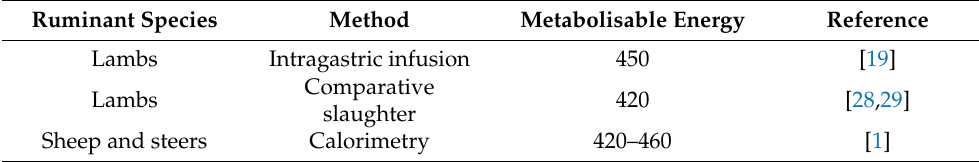
Table 1. Maintenance metabolisable energy requirement (kJ/kg W .75 ) estimates by